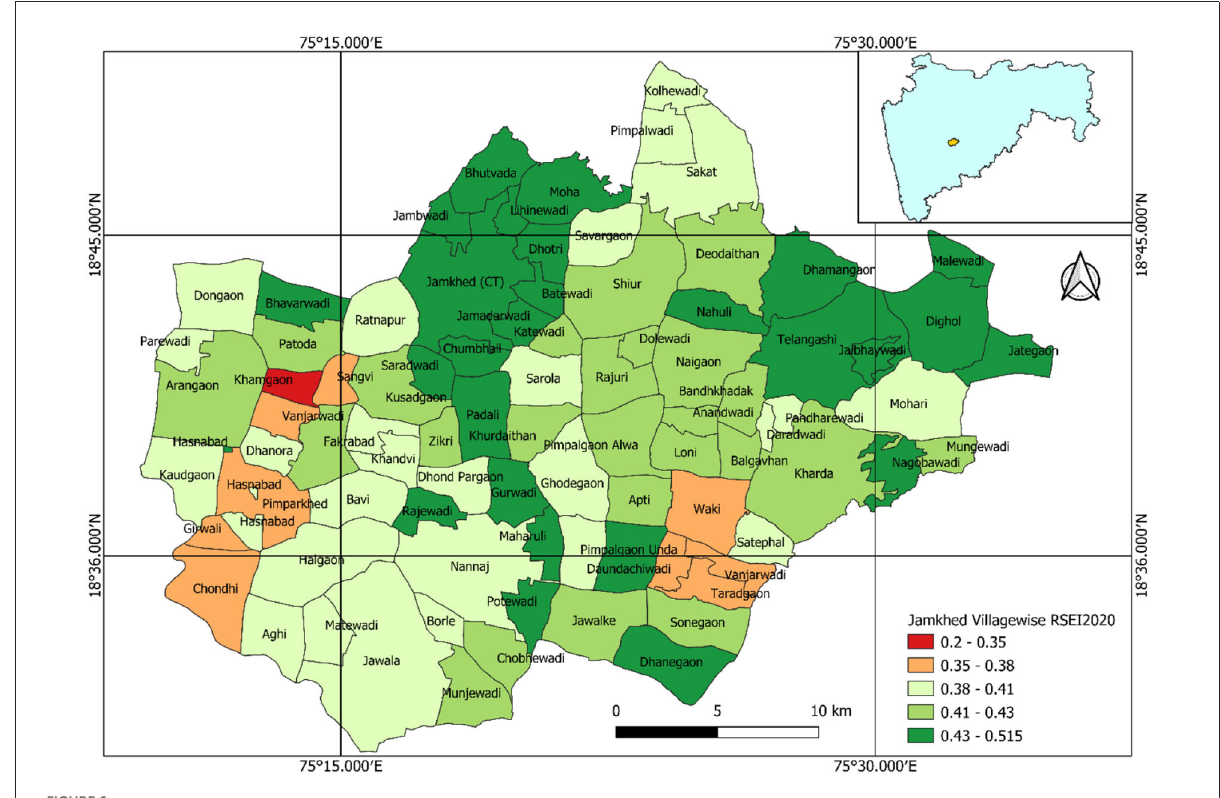
FIGURE6 Village-wise RSEI of Jamkhed taluka for the year